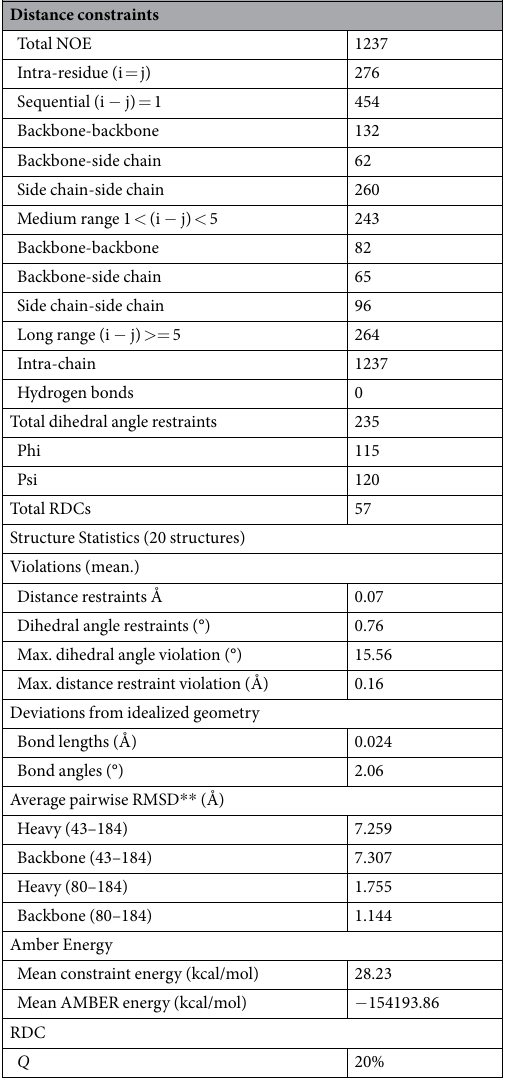
Table 2. Structure quality report. ** Pairwise RMSD was calculated among 20 refined structures for the full- length form (NTE + Grx domain; residues 43–184) and for the Grx domain only (residues